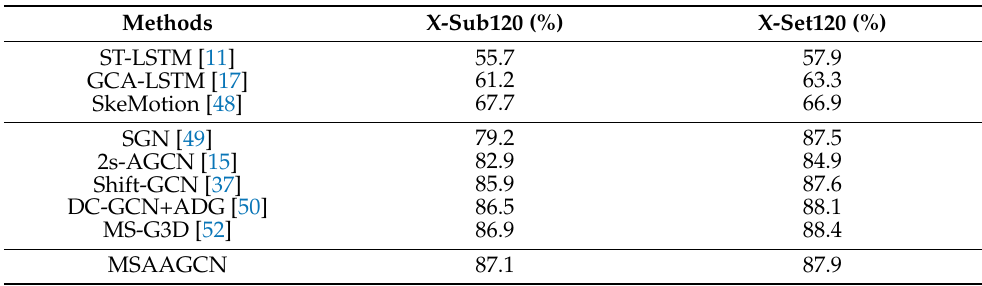
Table 6. Comparisons of the Top-1 recognition accuracy with the state-of-the-art methods on the NTU RGB+D120 dataset.